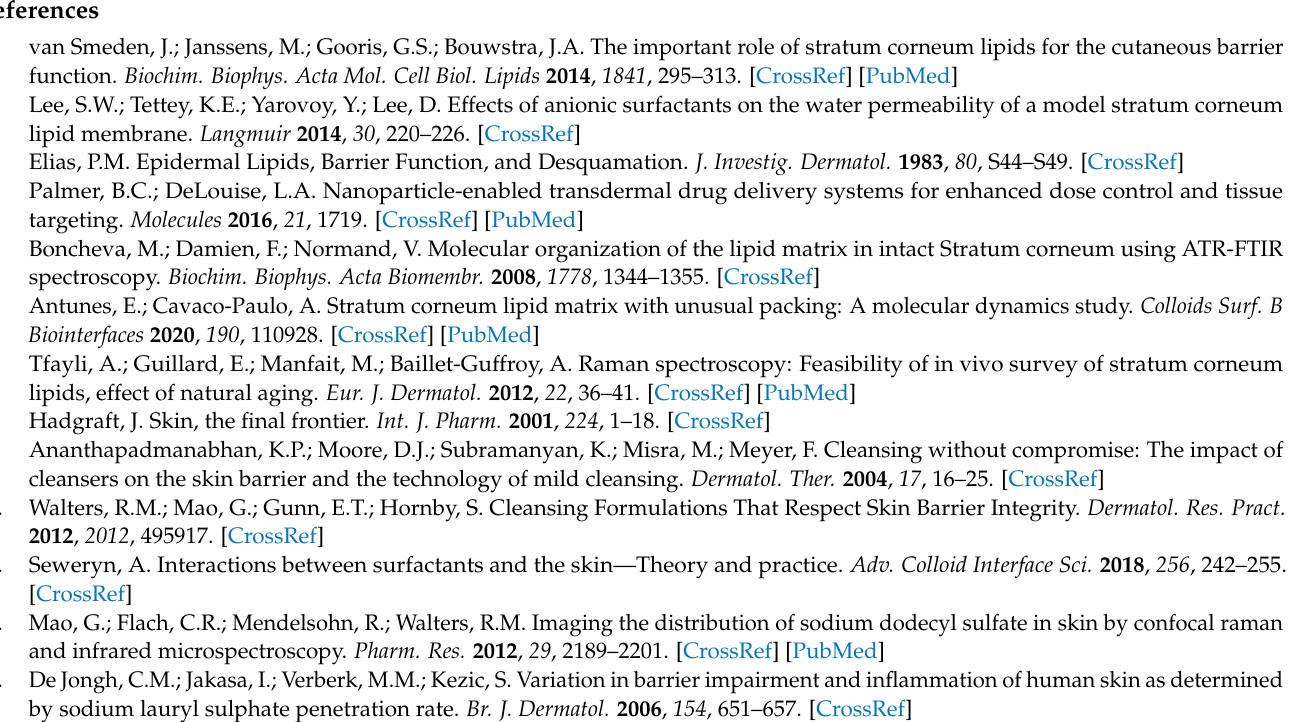
Figure S2: Structure and order of events of the study. Figure S3: Skin reaction of participant S005 to the different test